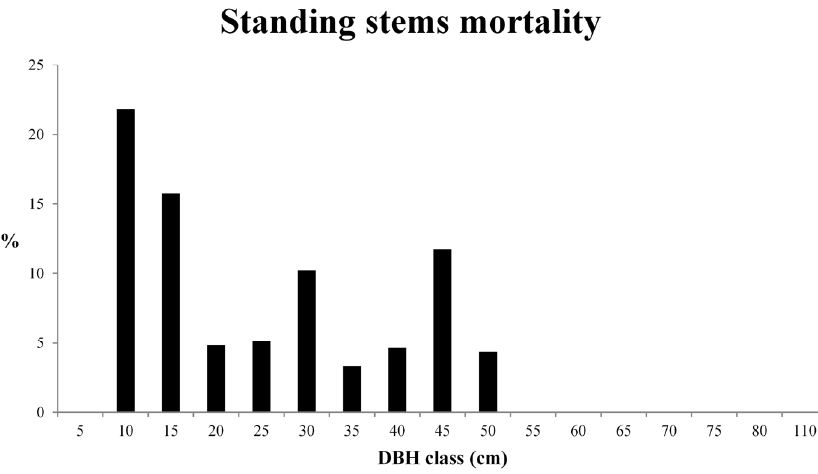
Figure 6. Stem mortality sorted by diameter class.